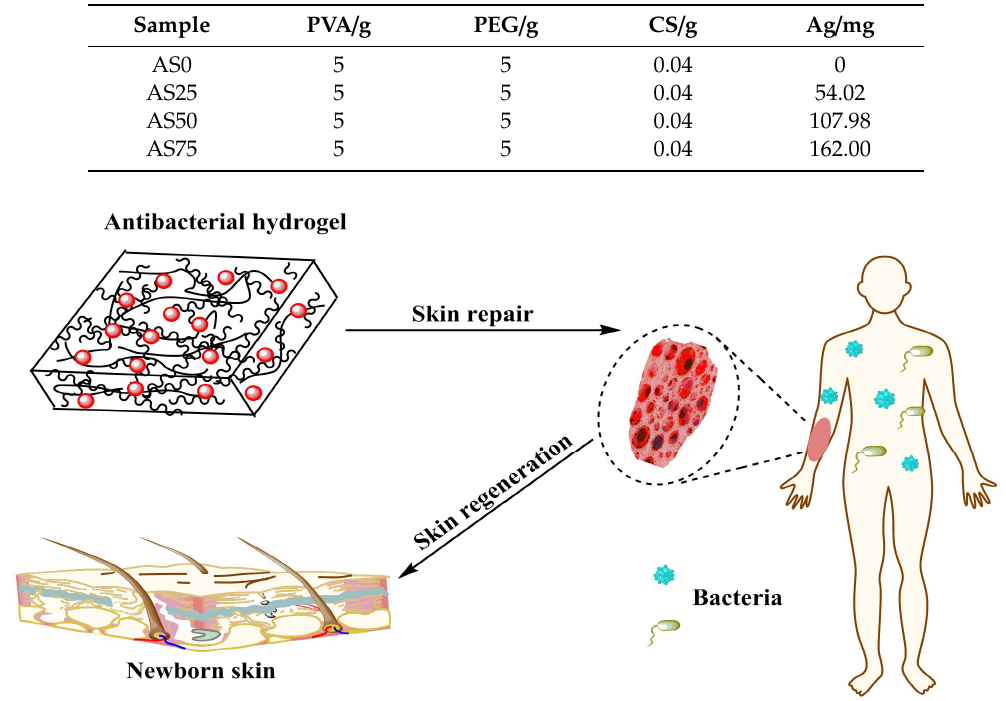
Table 1. The composition of the antibacterial hydrogel.